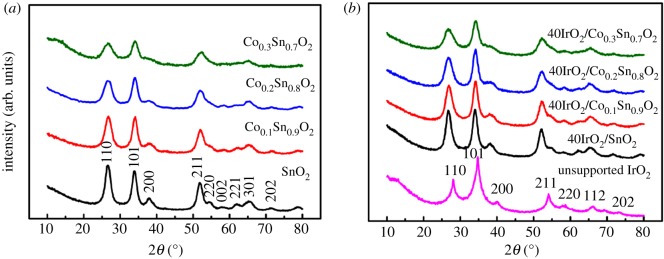
XRD patterns of the (a) CoxSn1−xO2; (b) 40IrO2/CoxSn1−xO2 (x = 0, 0.1, 0.2, 0.3) and unsupported IrO2.